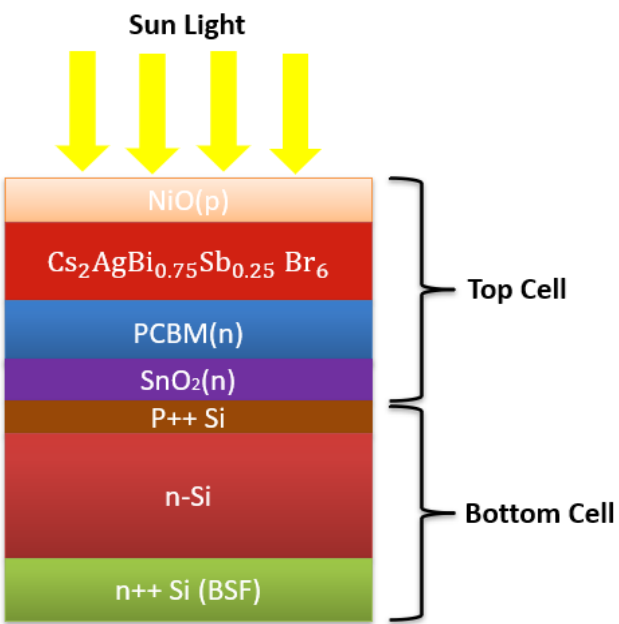
Figure 1. Tandem solar cell structure based on a bottom sub-cell of n-type silicon and a top cell of lead-free perovskite (hole transport layer: NiO; absorber: Cs 2 AgBi 0.75 Sb 0.25 Br 6 ; electron transport layers: PCBM and SnO 2 ).